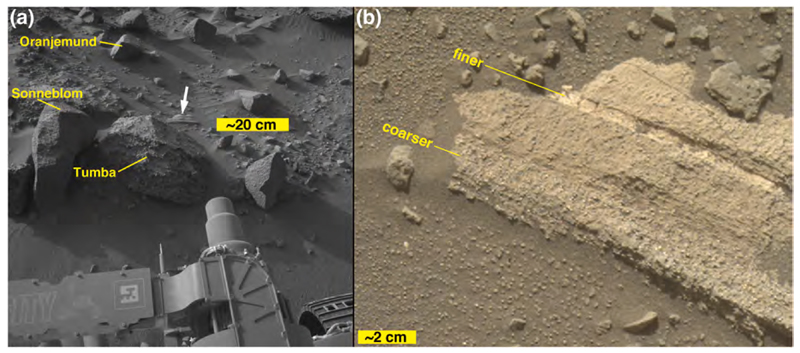
Angular sandstone cobble with fine-grained interbeds. (a) Location (white arrow) of the cobble relative to the larger boulders in the rover workspace during sols 1405–1410. (b) Highest spatial resolution view of the cobble. Coarser grains are ~700 μm; the skyward rock face cuts steeply across the original bedding. A recessed interval of ~1 cm thickness consists of grains too small to resolve.